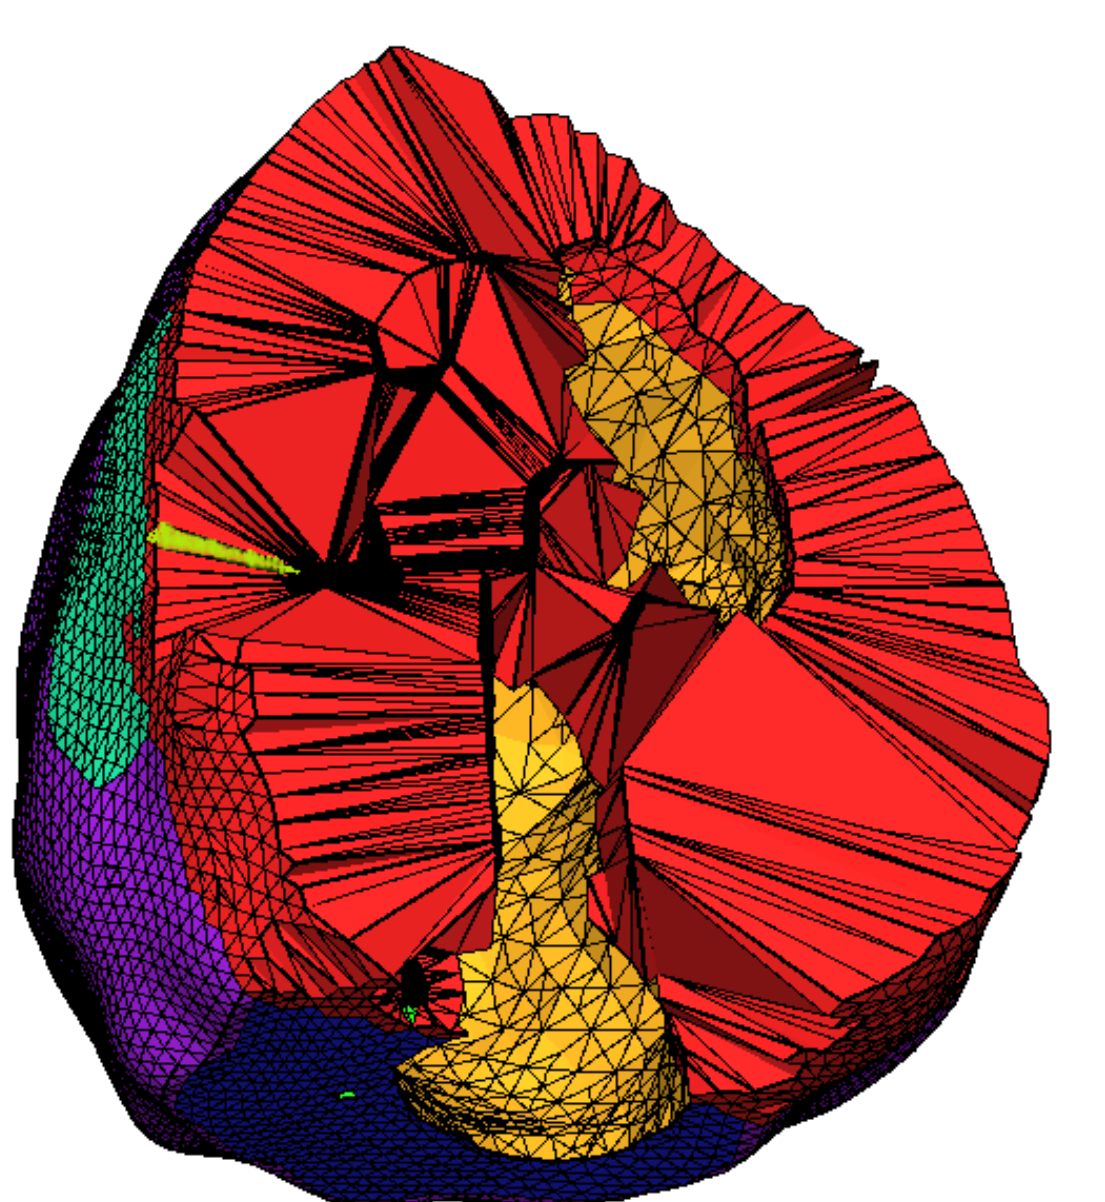
Figure 7. The real geometric model of the bouton filled by a three-dimensional mesh fitted to the two dimensional mesh shown in Figure 6. The mesh has been generated by using TetGen with no optimization. The quality of the mesh is very low because of the presence of a lot of needle-shaped tetrahedra what can be observed in the cross section. The artificial cut— blue , the inside of the mitochondrion— yellow , the surface of the bouton— purple , the cut surface— red . An example tetrahedron that has one vertex in the synthesis zone and the other in the release site is marked with bright lime